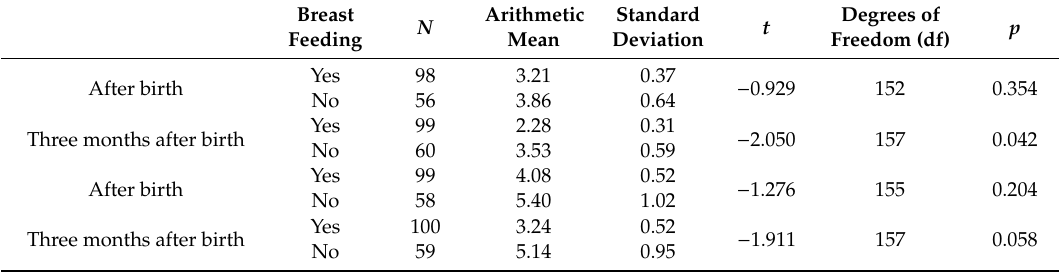
Table 4. Testing the di ff erence in depression and anxiety during pregnancy, after birth, and three months after birth in mothers who breastfed and those who did not three months after birth. Breast Arithmetic Standard N Feeding Mean